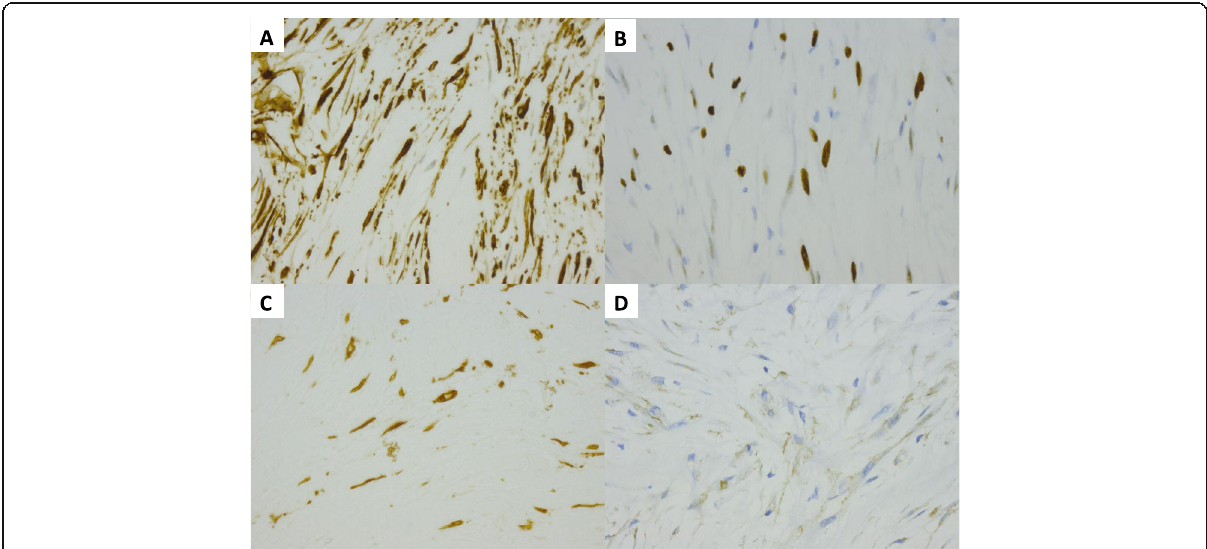
Fig. 2 Immunohistochemistry. Staining patterns for α SMA ( a ), p63 ( b ), CK AE1/AE3 ( c ) and β -catenin ( d ). (IHC × 400). There is a co-expression in both the spindle cells and the more epithelioid cells for p63 and CK